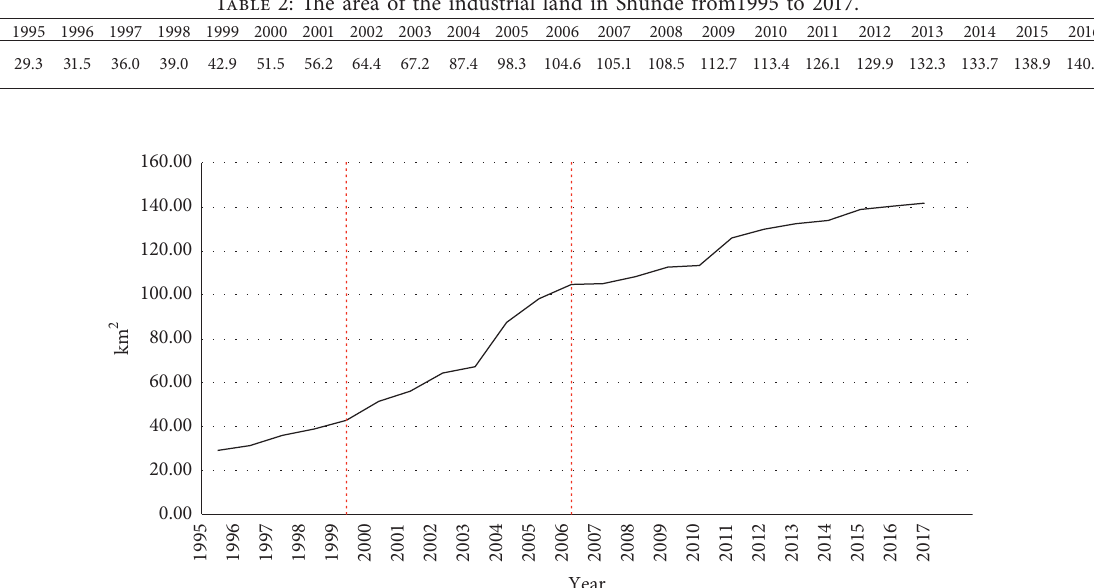
Figure 5: Variation trend of the industrial land area in Shunde from 1995 to 2017.